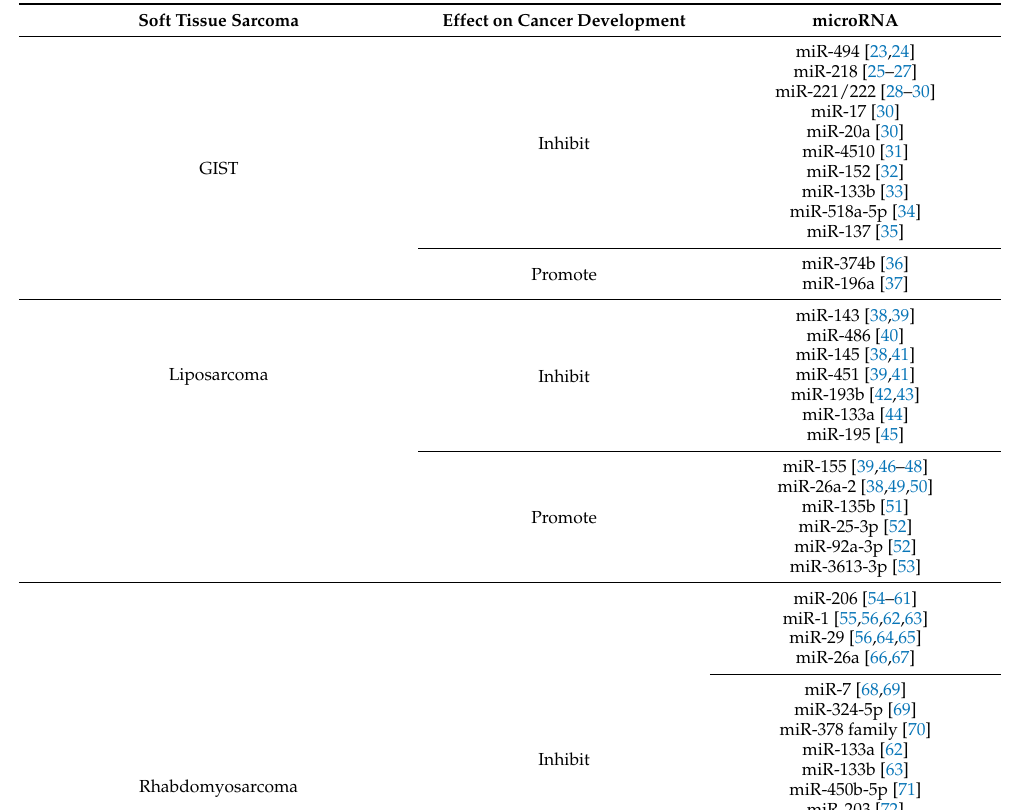
Table 1. Differential expression of miRNAs and their roles in cancer development in soft tissue